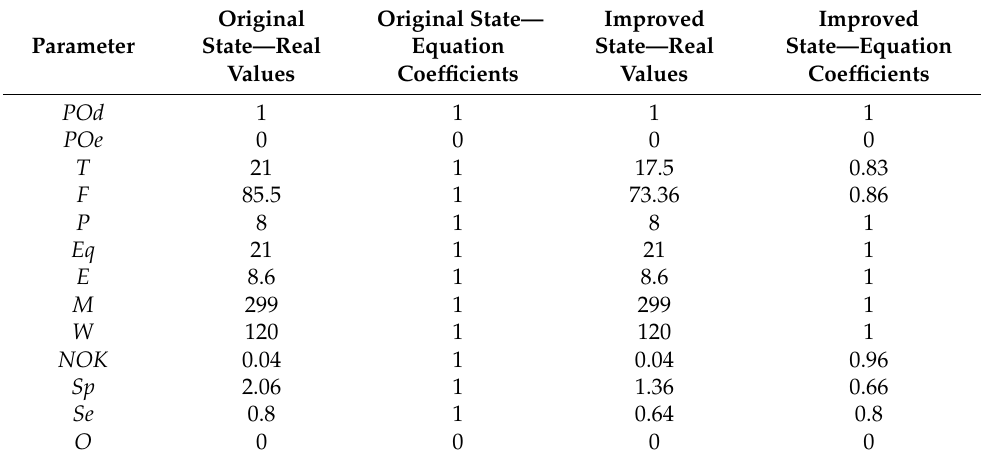
Table 5. Parameters for calculation of process ideality—original to improved state (packing process).